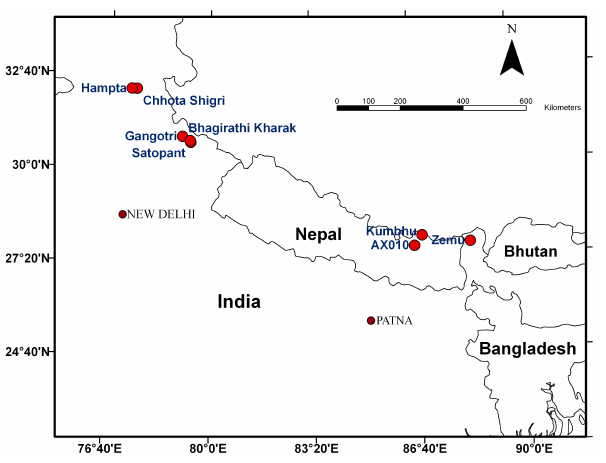
Fig. 1. Map showing the positions of the glaciers considered for the study. International borders are shown.